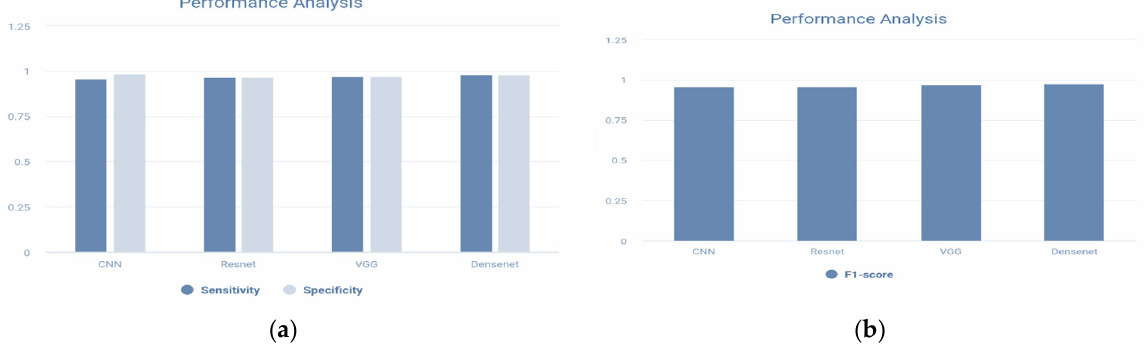
Figure 10. ( a ) Sensitivity, specificity vs. models. ( b ) F1-score vs. models.